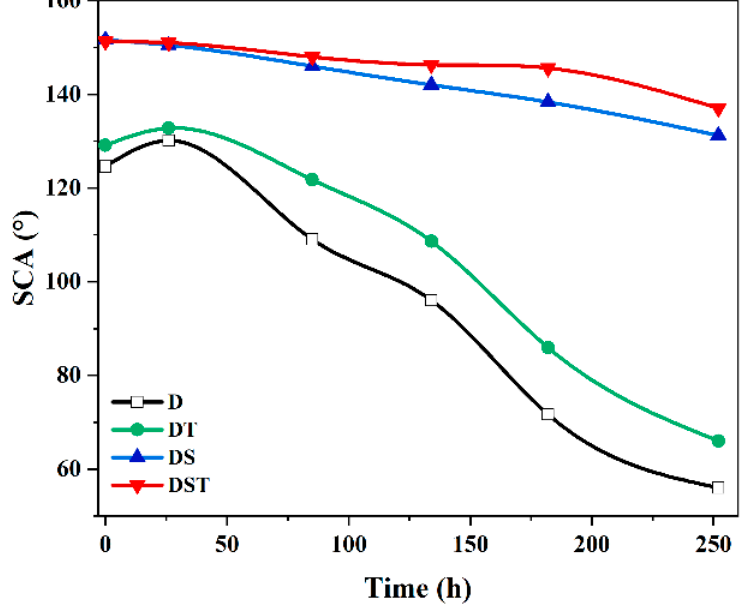
Figure 7. Variation in the static contact angles during the thermal ageing test.